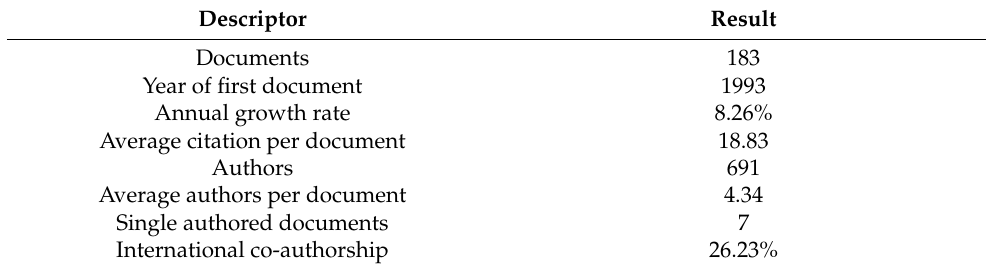
Table 1. Main descriptor of the retrieved documents employed for this